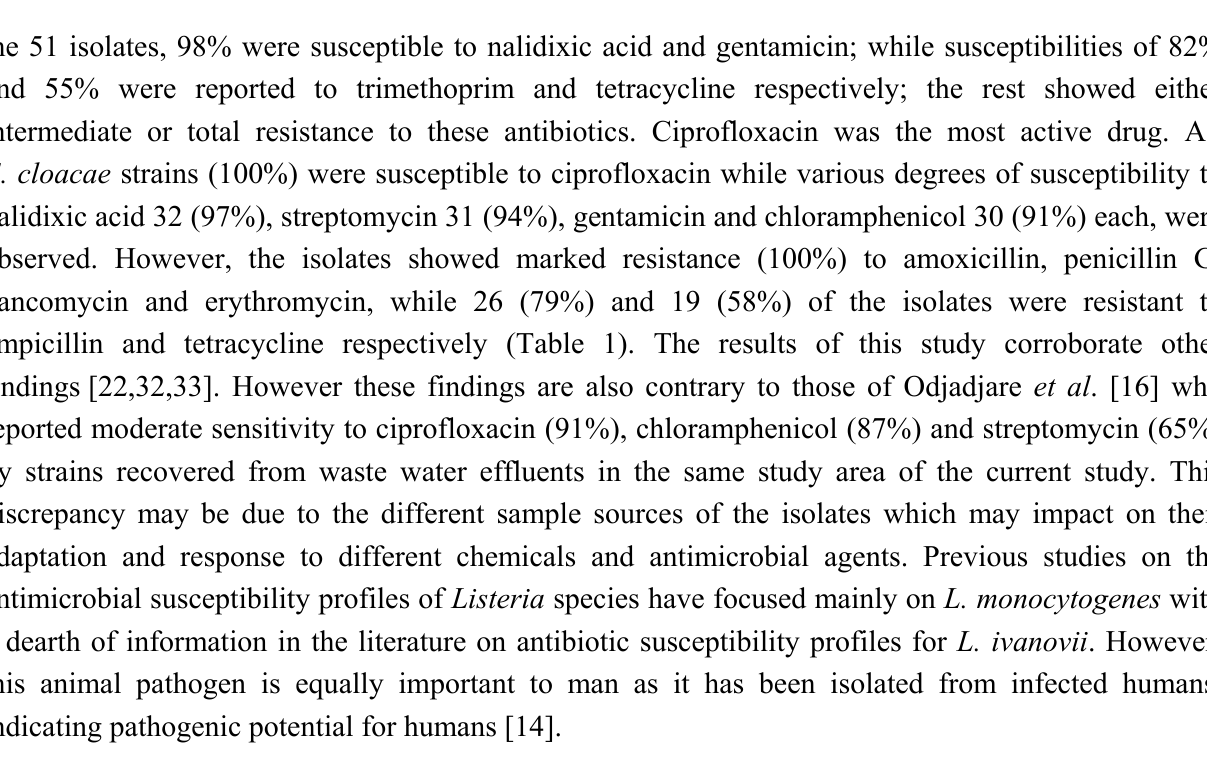
Table 1. Antimicrobial susceptibility profile of L. ivanovii and E. cloacae isolated from ready-to-eat